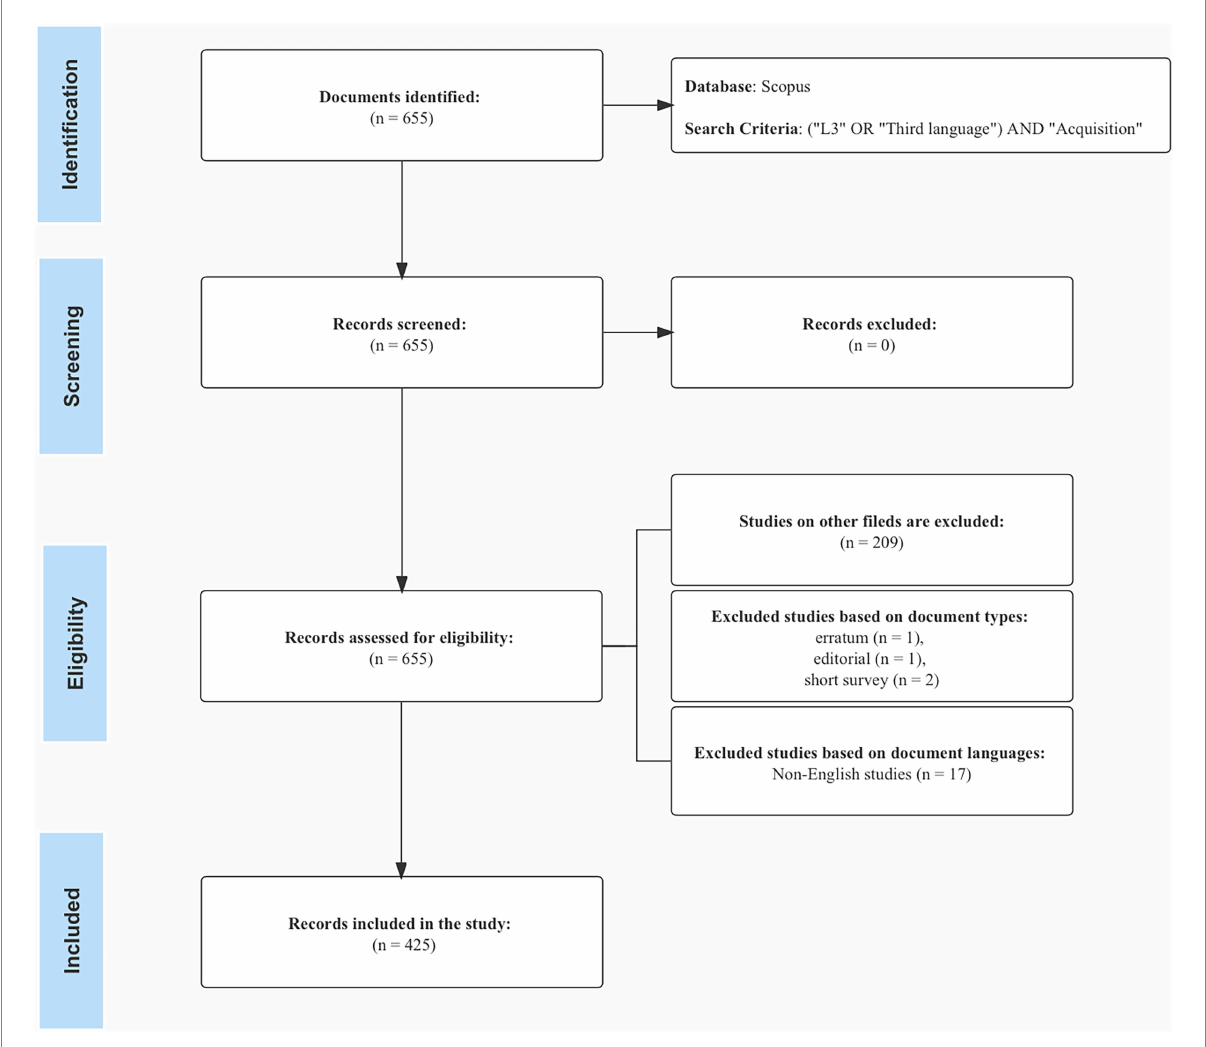
FIGURE 1 Data collection flow chart, adapted from Aria and Cuccurullo (2017) and Firdaus et al.